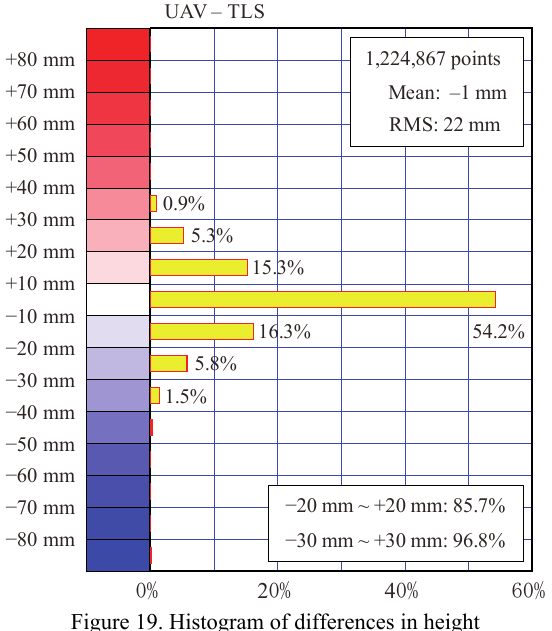
Figure 19. Histogram of differences in height between UAV photogrammetry and